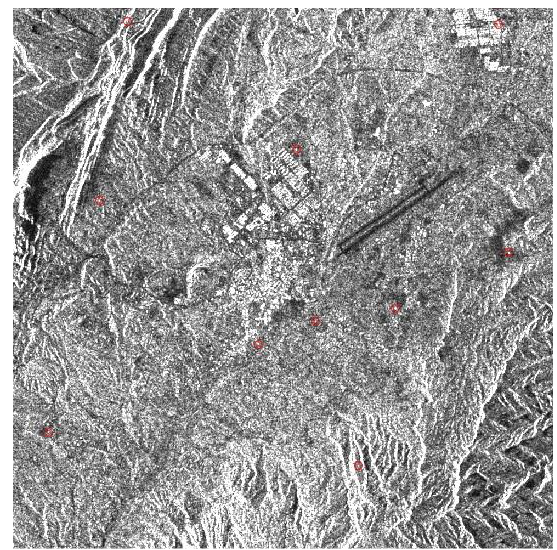
Figure 4. 10 of the best match points on master image Evaluation factor for matching accuracy is manual measurement for random points of grid. then 50 points are selected randomly and accuracy of matching process are observed. The result show that 43 points have one pixel diffrence with the corresponding point and the rest have two pixels diffrence with the corresponding point. grid of points on master image and matched point on slave image are shown in figure